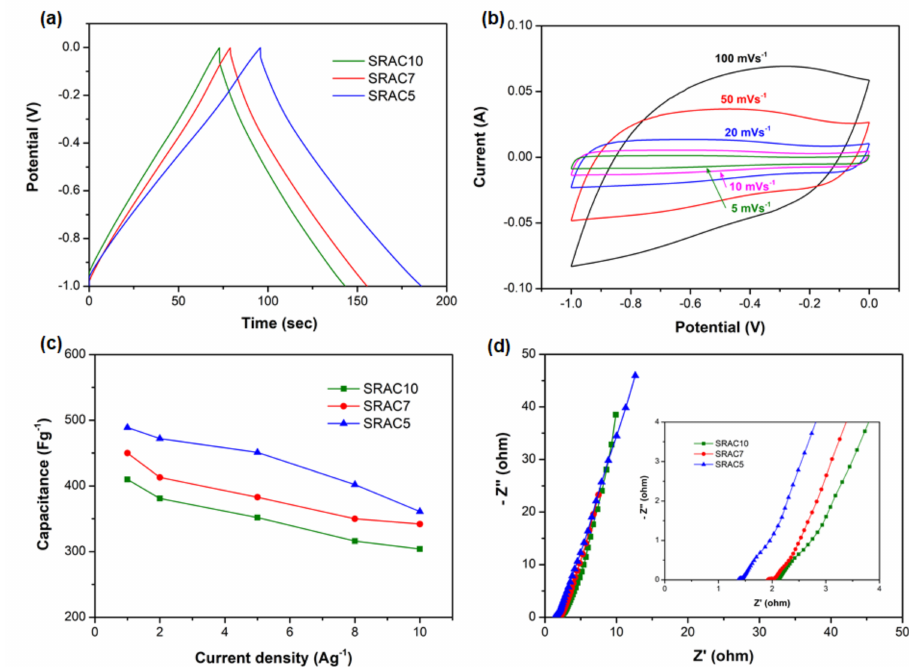
Figure 5. Electrochemical characteristics of SRAC / Ni electrodes in 6 M LiNO 3 aqueous electrolyte in a three-electrode system: ( a ) GCD curves at 5 A g − 1 for SRAC / Ni electrodes; ( b ) CV curves of SRAC5 / Ni electrode at various scan rates; ( c ) specific capacitances of SRAC / Ni electrodes at various current densities; and ( d ) Nyquist plots of SRAC / Ni